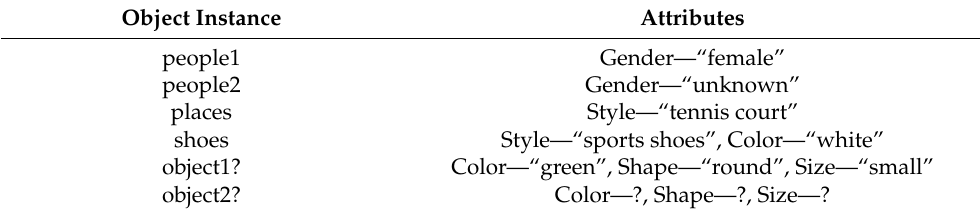
Table 2. The relationships between instances in Figure 1. Relationships Map r 1 —“on” r 1 ( people1, places ) , r 1 (people2, places) r 2 —“over” r 2 (object1,